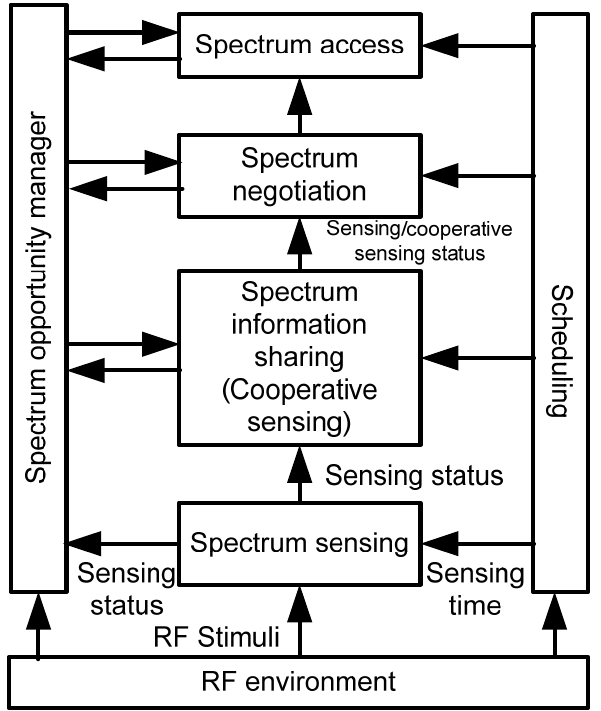
Figure 6. Logical framework of spectrum